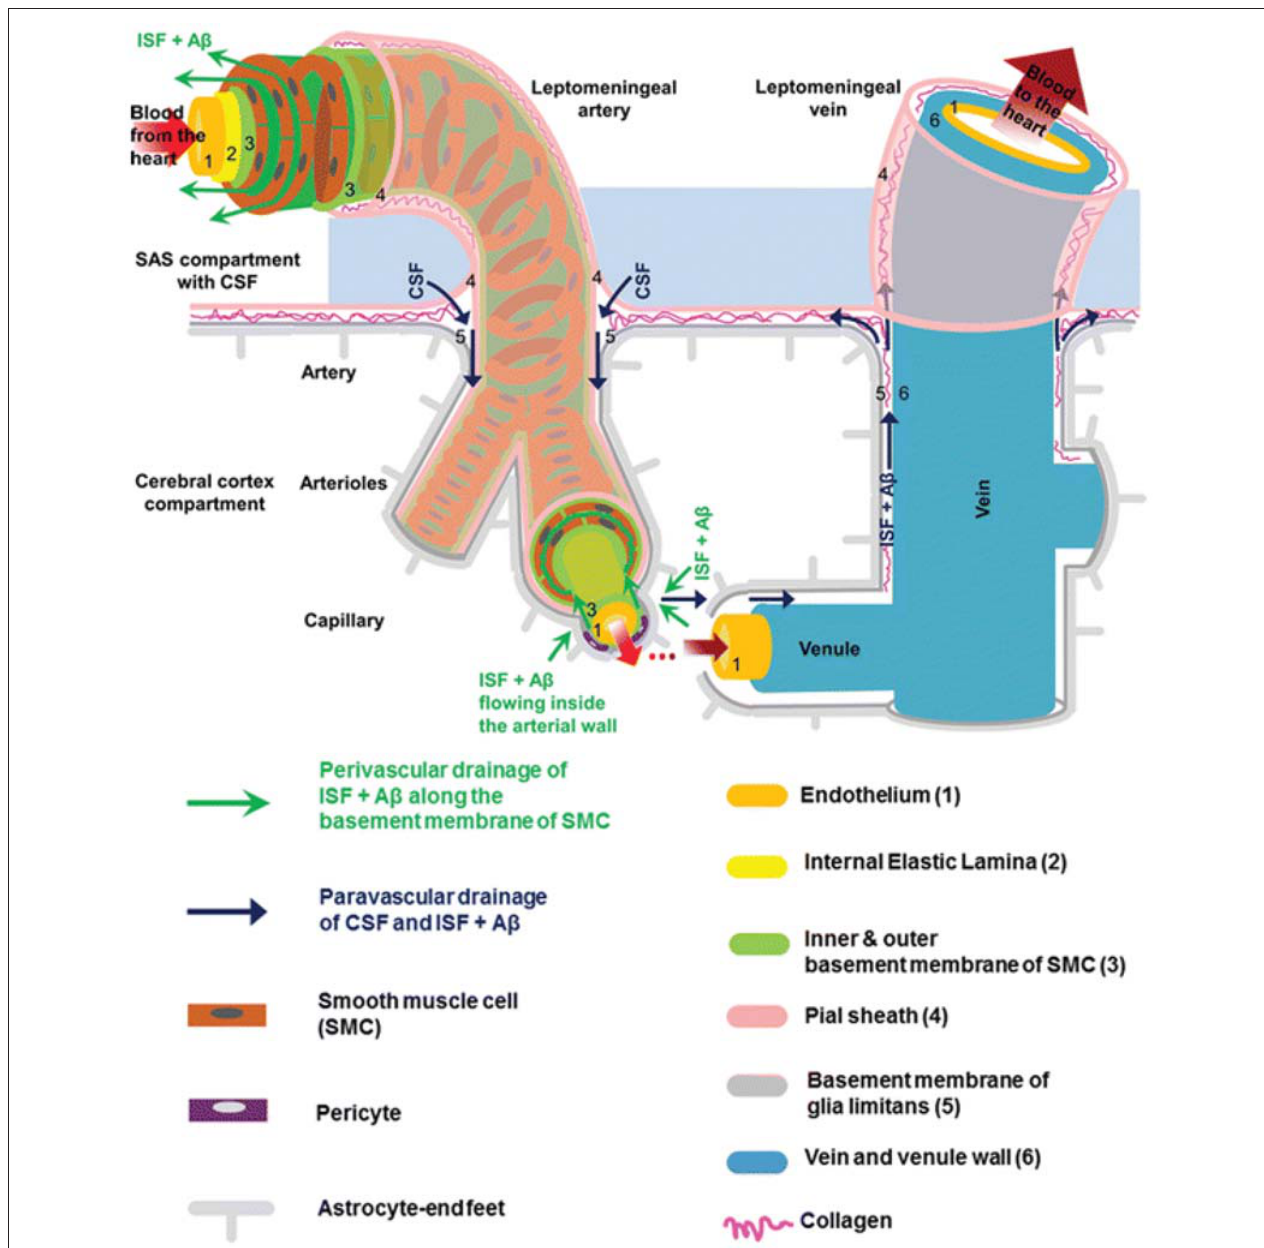
FIGURE 1 | Anatomy of the paravascular and perivascular spaces. The arterial paravascular space is bounded internally by the pial sheath (4) and externally by the basement membrane of glia limitans (5) . The venous paravascular space is bounded internally by the vein wall (6) and externally by the glia limitans. The perivascular space is found within the middle layers of the basement membrane of arterial smooth muscle cells (3) . No perivascular space is present in venous vasculature. In each space, the direction of fluid flow and waste clearance, such as amyloid beta (A β ), is depicted with arrows. Reprinted with permission © Bakker et al.